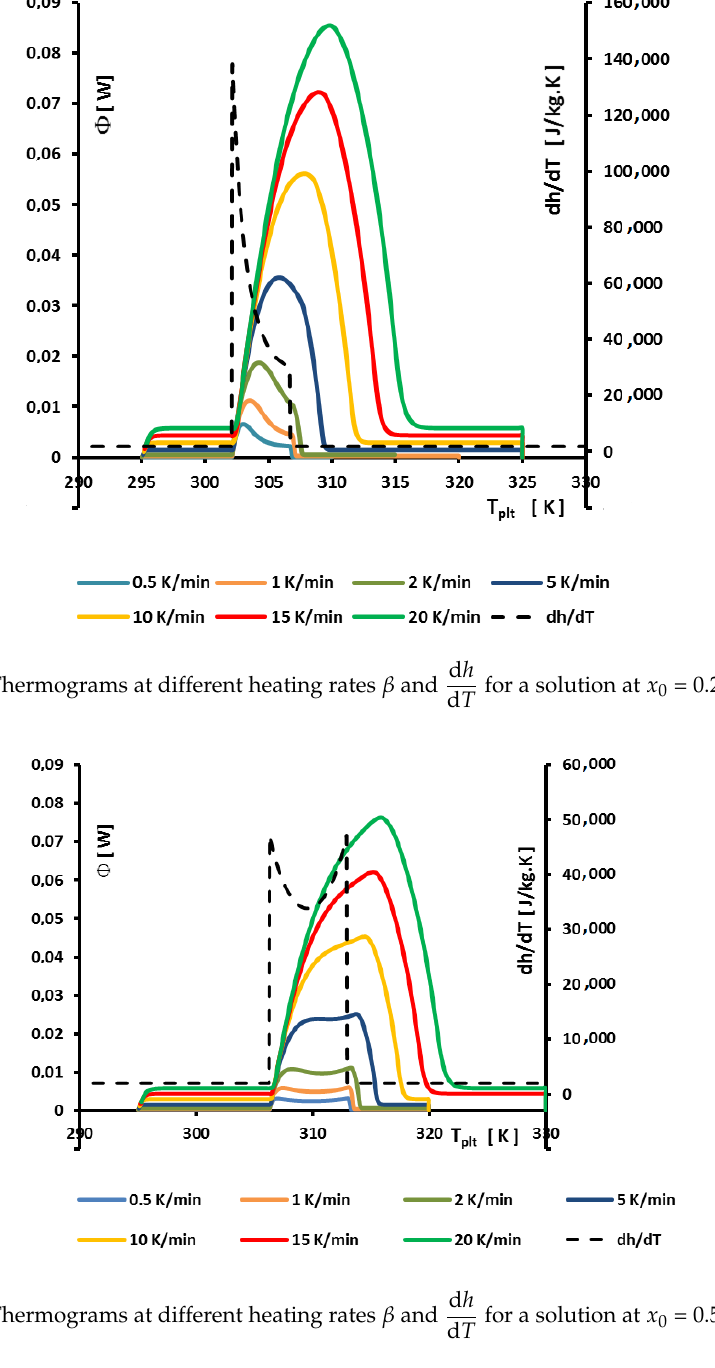
Figure 27. Thermograms at different heating rates β and